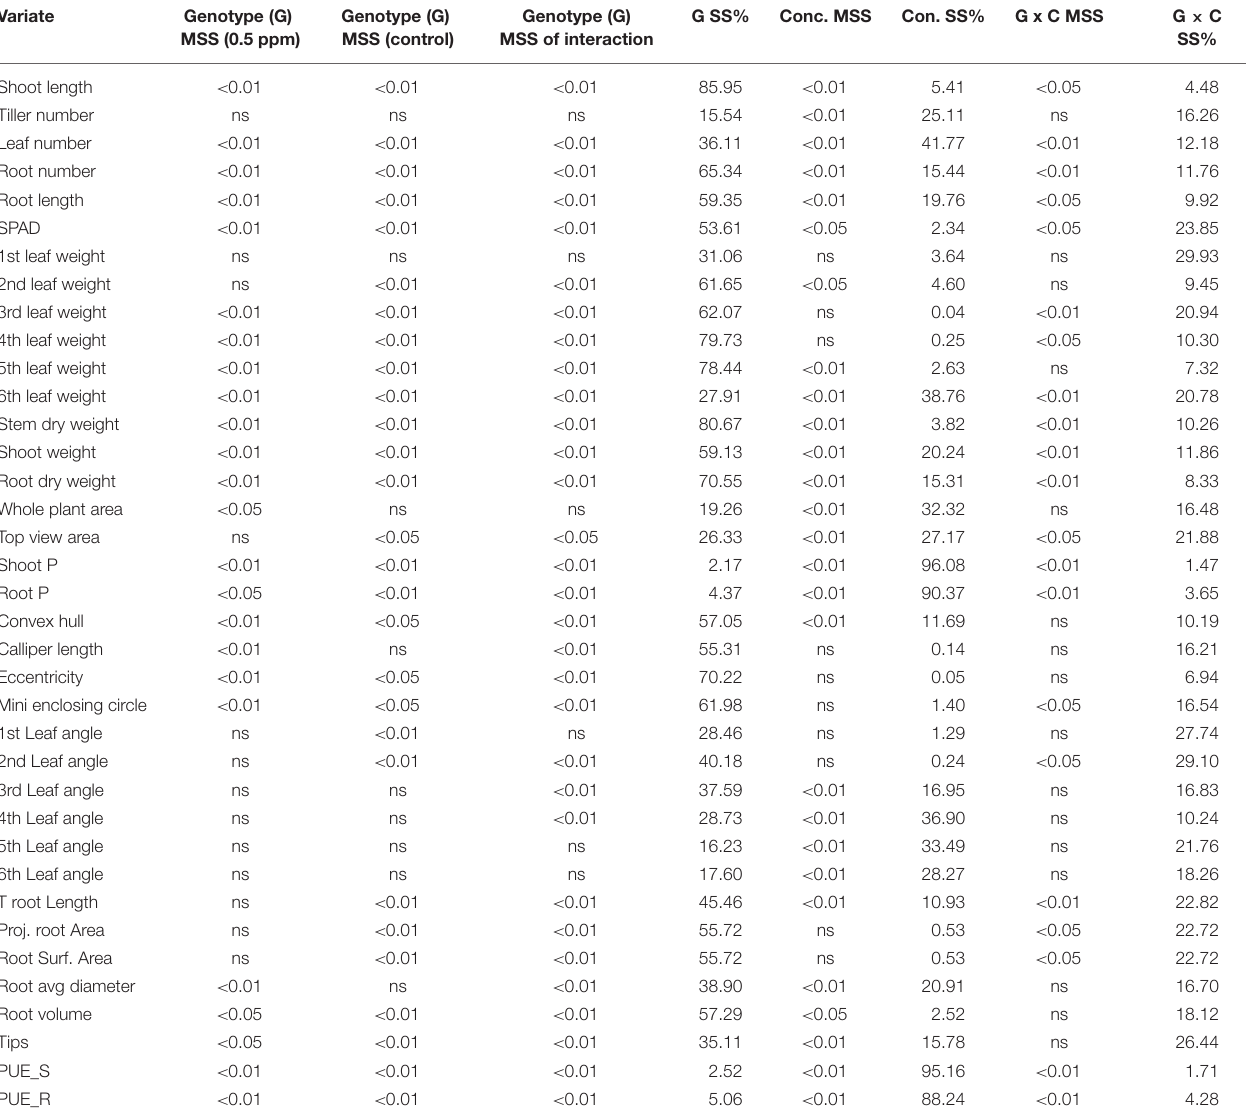
TABLE 2 | Analysis of variance for various traits under deficiency (0.5 ppm) and control concentration of phosphorus and genotype interaction effect. Variate